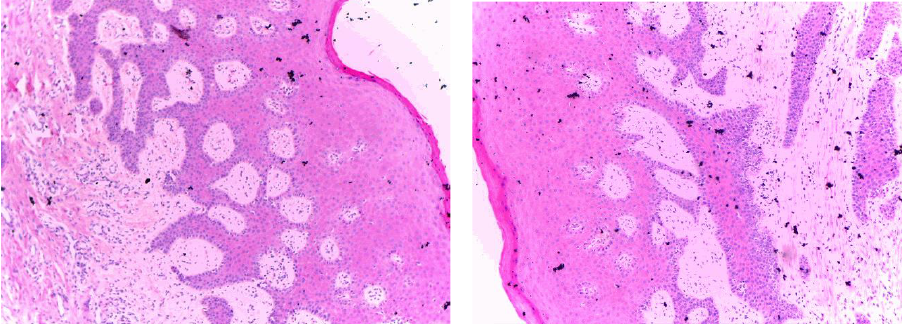
Figure 2. Histopathological examination of the myrrh group .